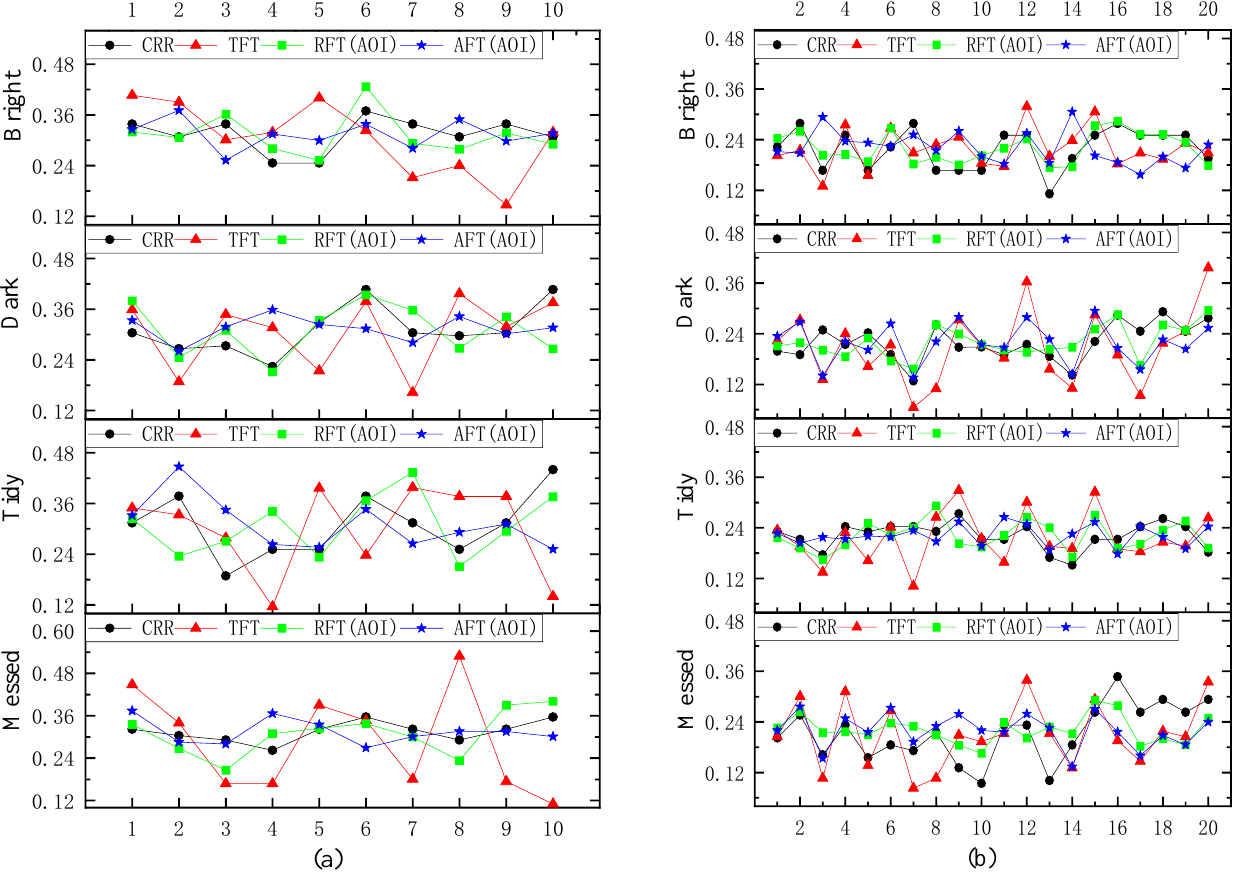
Figure 8. Standardized data of each indicator of the subjects: ( a ) experienced workers; ( b ) novice workers.